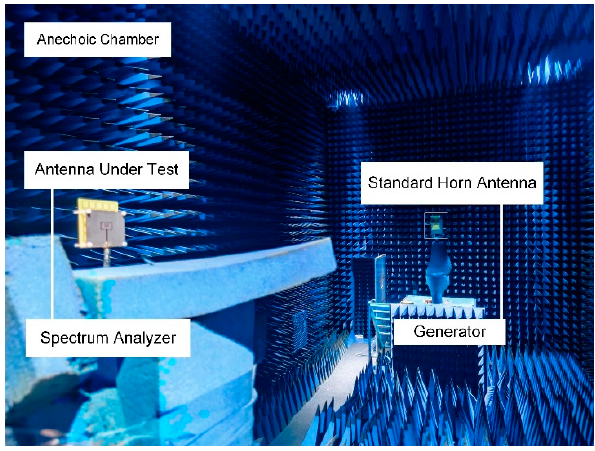
Figure 11. The antenna measurement environment in the anechoic chamber.